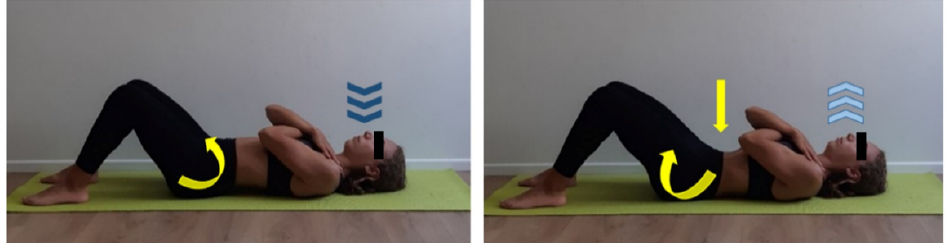
Figure 3. Lumbar mobilization exercise. Supine position, flexed legs. Cross both upper limb on chest and place each hand on contralateral shoulder. Inhale (dark blue arrows) through the nose while performing a pelvis anteversion (curved yellow arrow) and exhale (light blue arrows) through the mouth while performing a pelvis retroversion (curved yellow arrow). Focus on perceiving abdomen getting downward during exhalation phase (yellow arrow). Five min work.